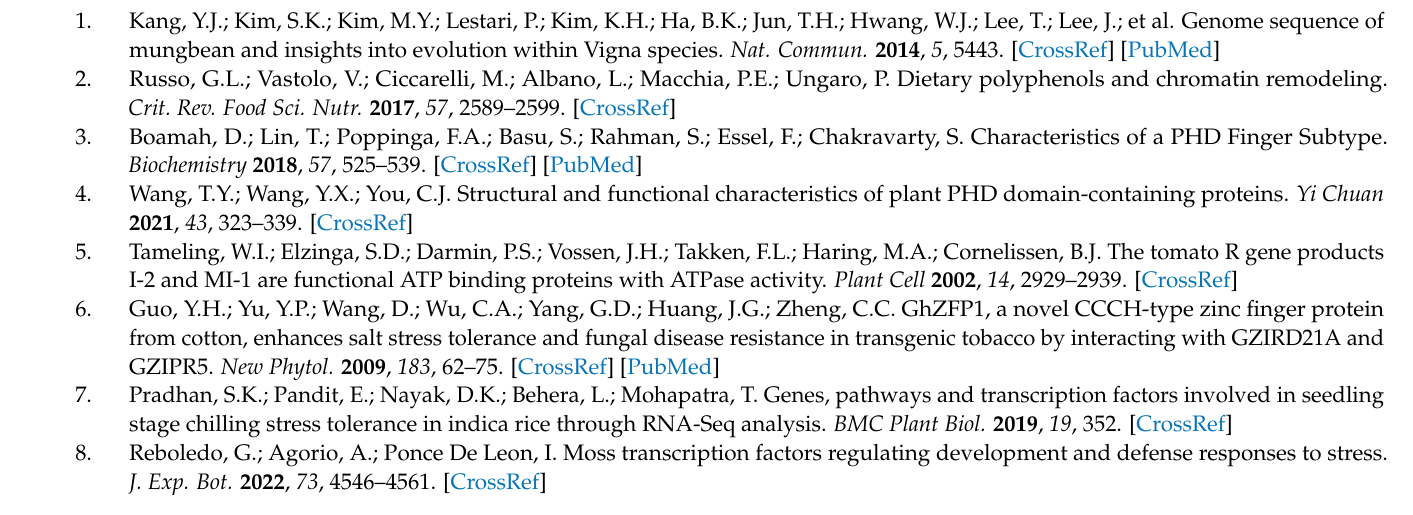
Table S6: Ka, Ks, and Ka/Ks statistics of VrPHDs; Supplementary Table S7: Ka, Ks, and Ka/Ks statistics of